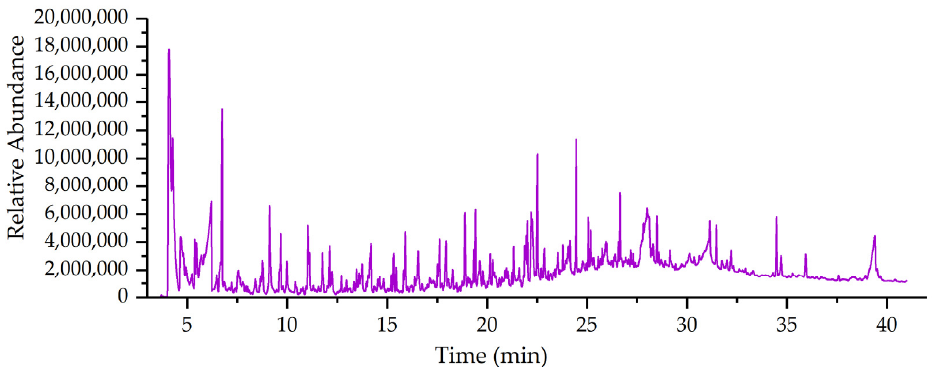
Figure 3. Total ion chromatograms of A. Bunge leaves by pyrolysis gas chromatography-mass spec- troscopy.